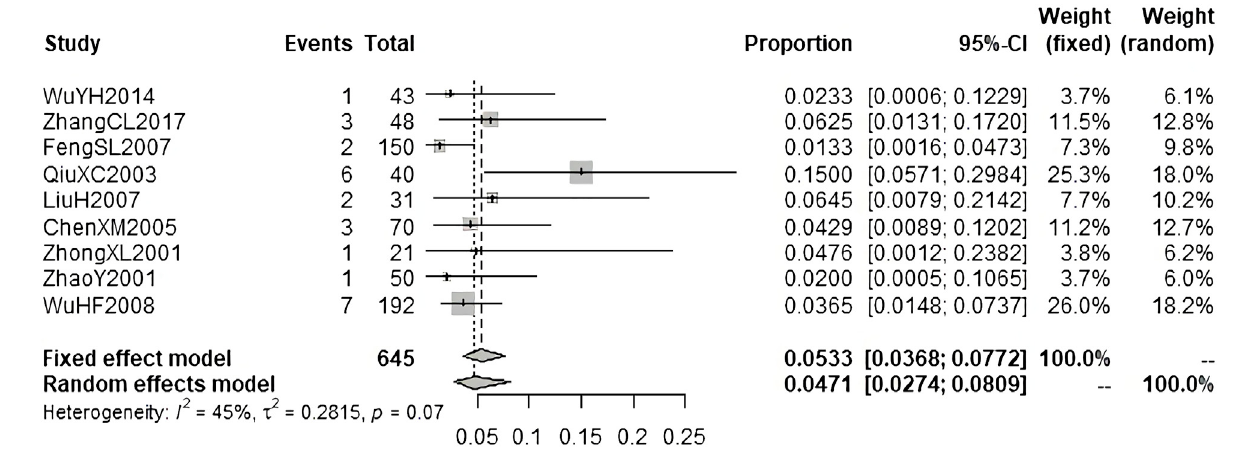
FIGURE 5 | Meta-analysis on ADR incidence of PDS.